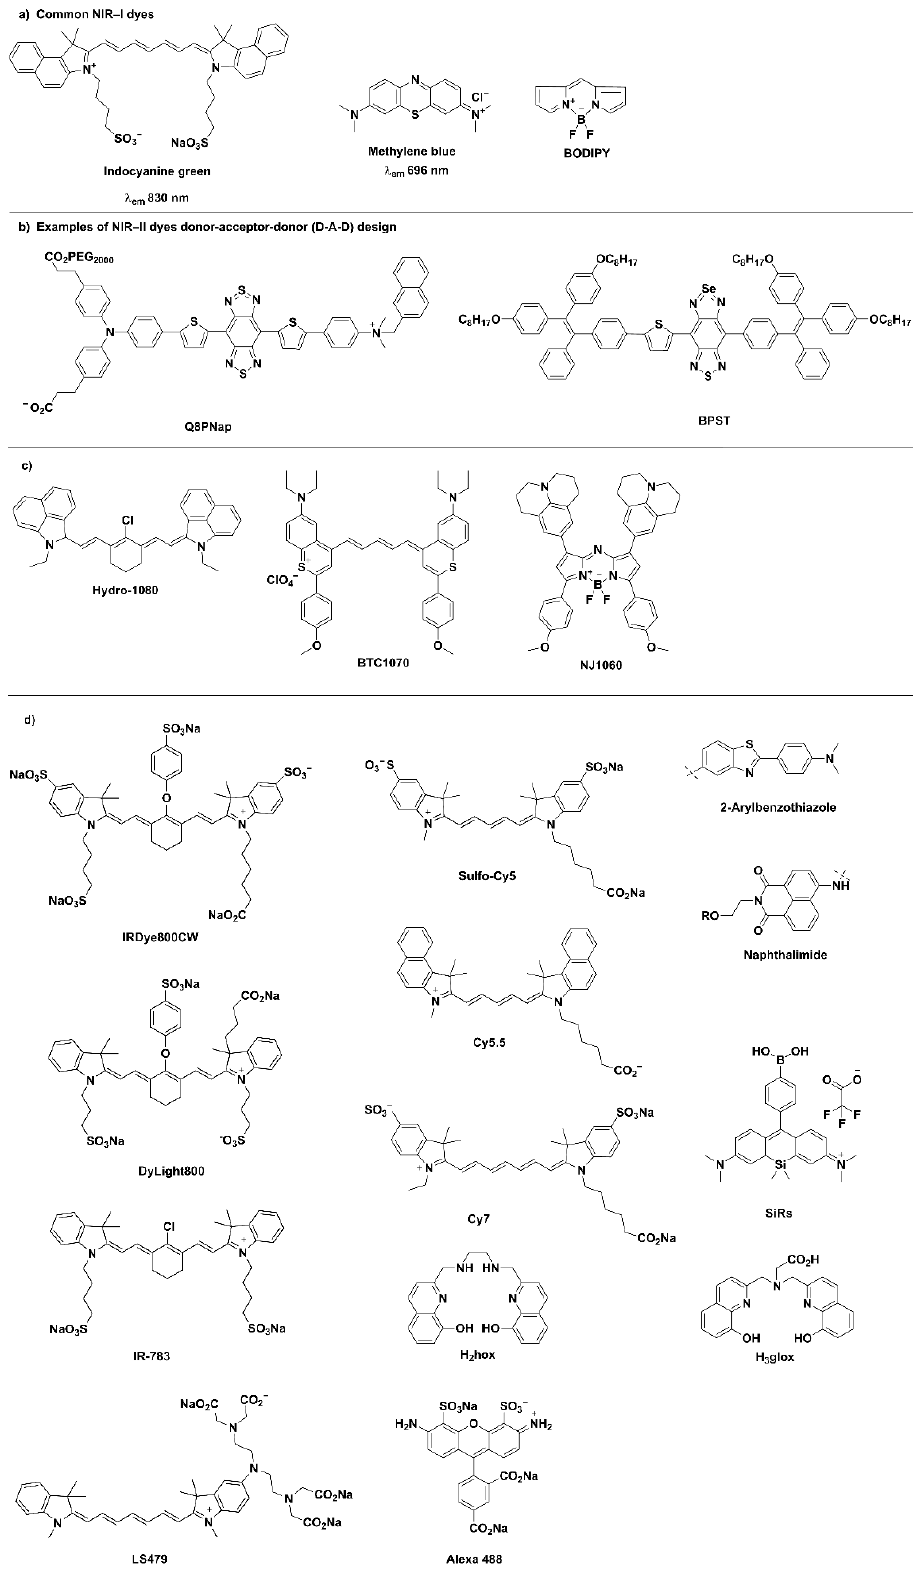
Figure 3. Representative examples of ( a ) Common NIR-I dyes, ( b ) NIR-II dyes that are based on the donor–acceptor–donor design, Q8PNap [25] and BPST [26], ( c ) Alternate NIR-II dyes: Hydro-1080 [27], BTC1070 [28] and NJ1060 [29] and ( d ) Additional fluorophores, not previously noted, that are relevant to Sections 3 and